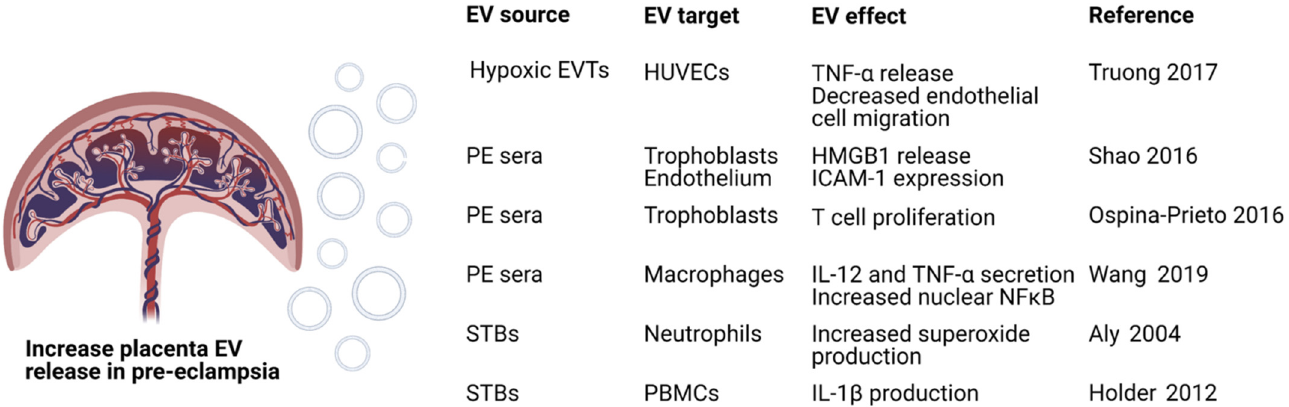
Figure 3. Effects of EVs on different cell types in PE.